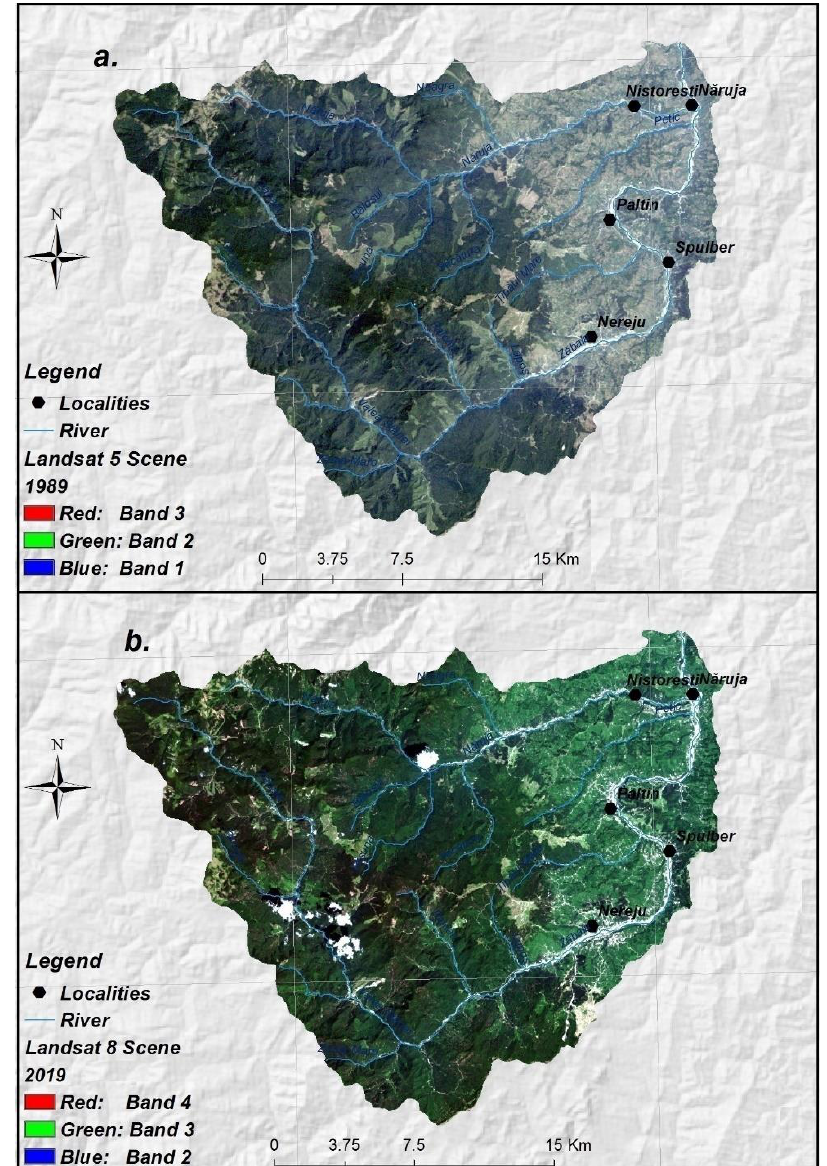
Figure 3. Landsat scenes: ( a ) 1989 and ( b ) 2019.